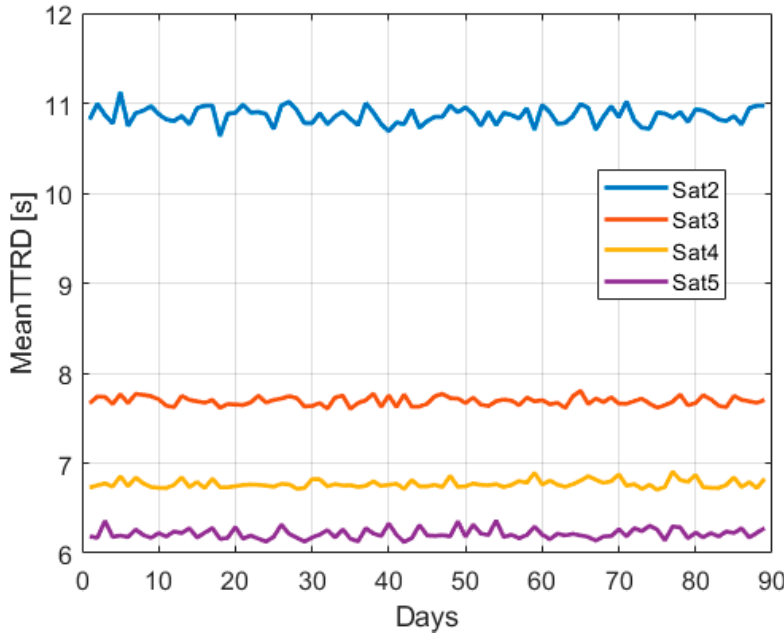
Figure 10. Daily mean TTRD over the whole observation period for two, three, four, and five connected satellites.